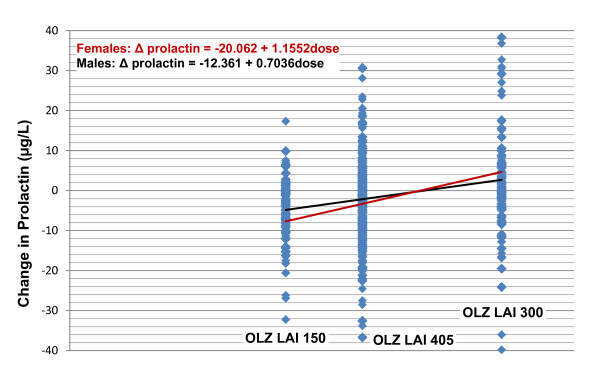
Regression scatterplots of mean change in prolactin at endpoint (LOCF) by dose and gender. Figure 2 shows the scatterplots, regression lines, and resulting equations for the relationship between endpoint prolactin change and dose, by gender. In the equation, "dose" refers to the calculated oral equivalent daily dose (10.7, 14.5, or 21.4 mg/day), not the actual injected dose. Abbreviations: OLZ LAI = olanzapine long-acting injection; OLZ LAI 150 = group receiving low-dose olanzapine LAI, 150 mg/2 weeks, approximate oral equivalent 10 mg/day (N = 140); OLZ LAI 405 = group receiving medium-dose olanzapine LAI, 405 mg/4 weeks, approximate oral equivalent 15 mg/day (N = 318); and OLZ LAI 300 = group receiving high-dose olanzapine LAI, 300 mg/2 weeks, approximate oral equivalent 20 mg/day (N = 141).